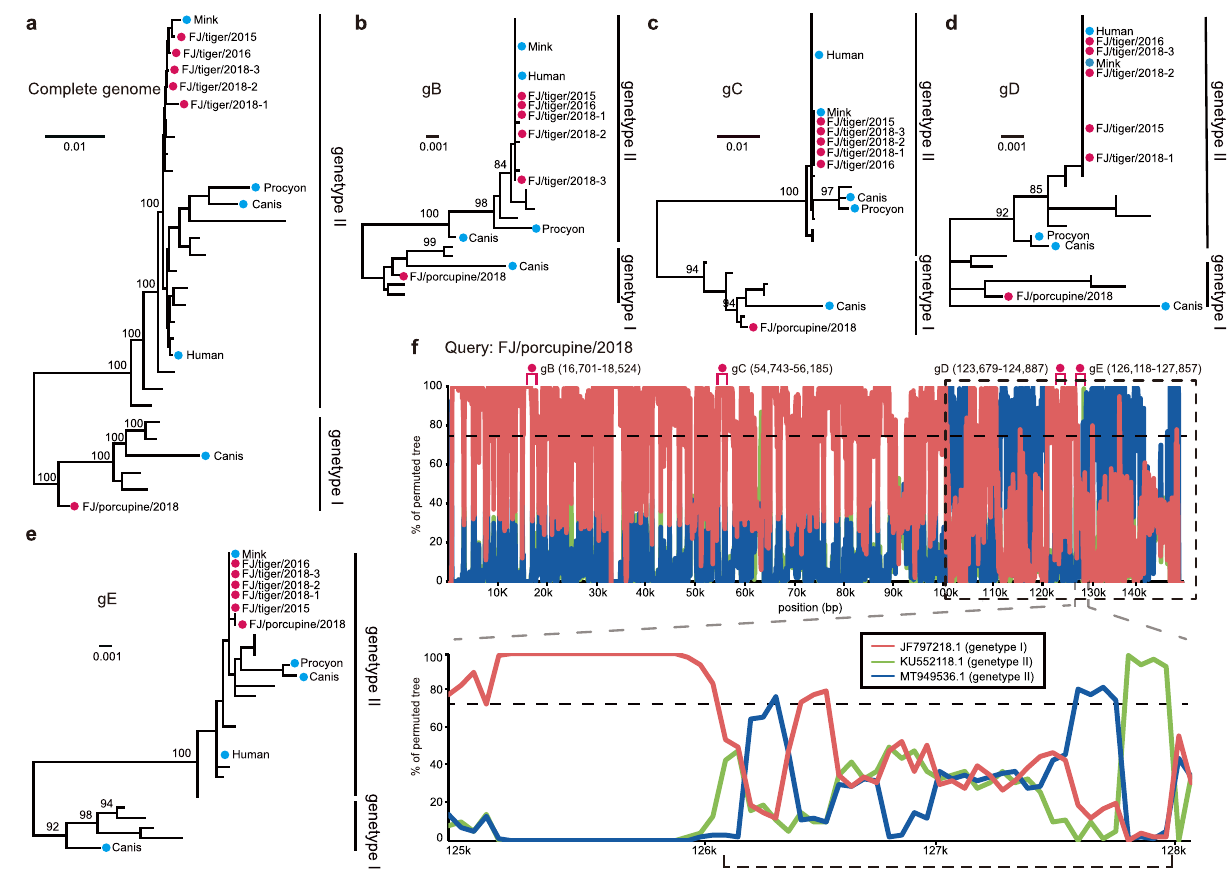
Fig.5|Phylogenetichistoryandrecombinationinpseudorabiesviruses(PRVs). The phylogenetictreeswereestimatedbased on a full genome sequences, and the b gB , ( c ) gC , d gD , and e gE genes, utilizing the best- fi t nucleotide substitution model obtained by IQ-TREE (Minh et al., 2020). All trees were midpoint rooted. Numbers (>80) above branches are percentage bootstrap values for the major nodes. The scale bar represents the number of substitutions per site. Red circles